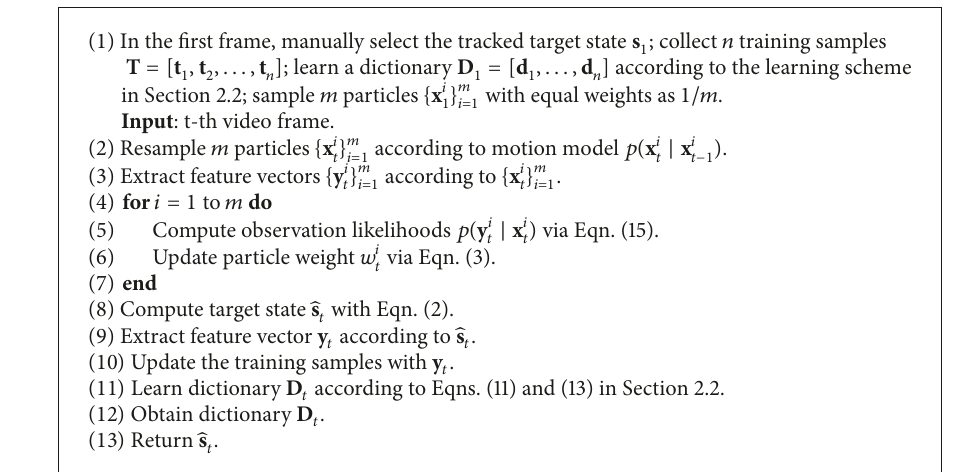
Algorithm 1: Proposed tracking algorithm.